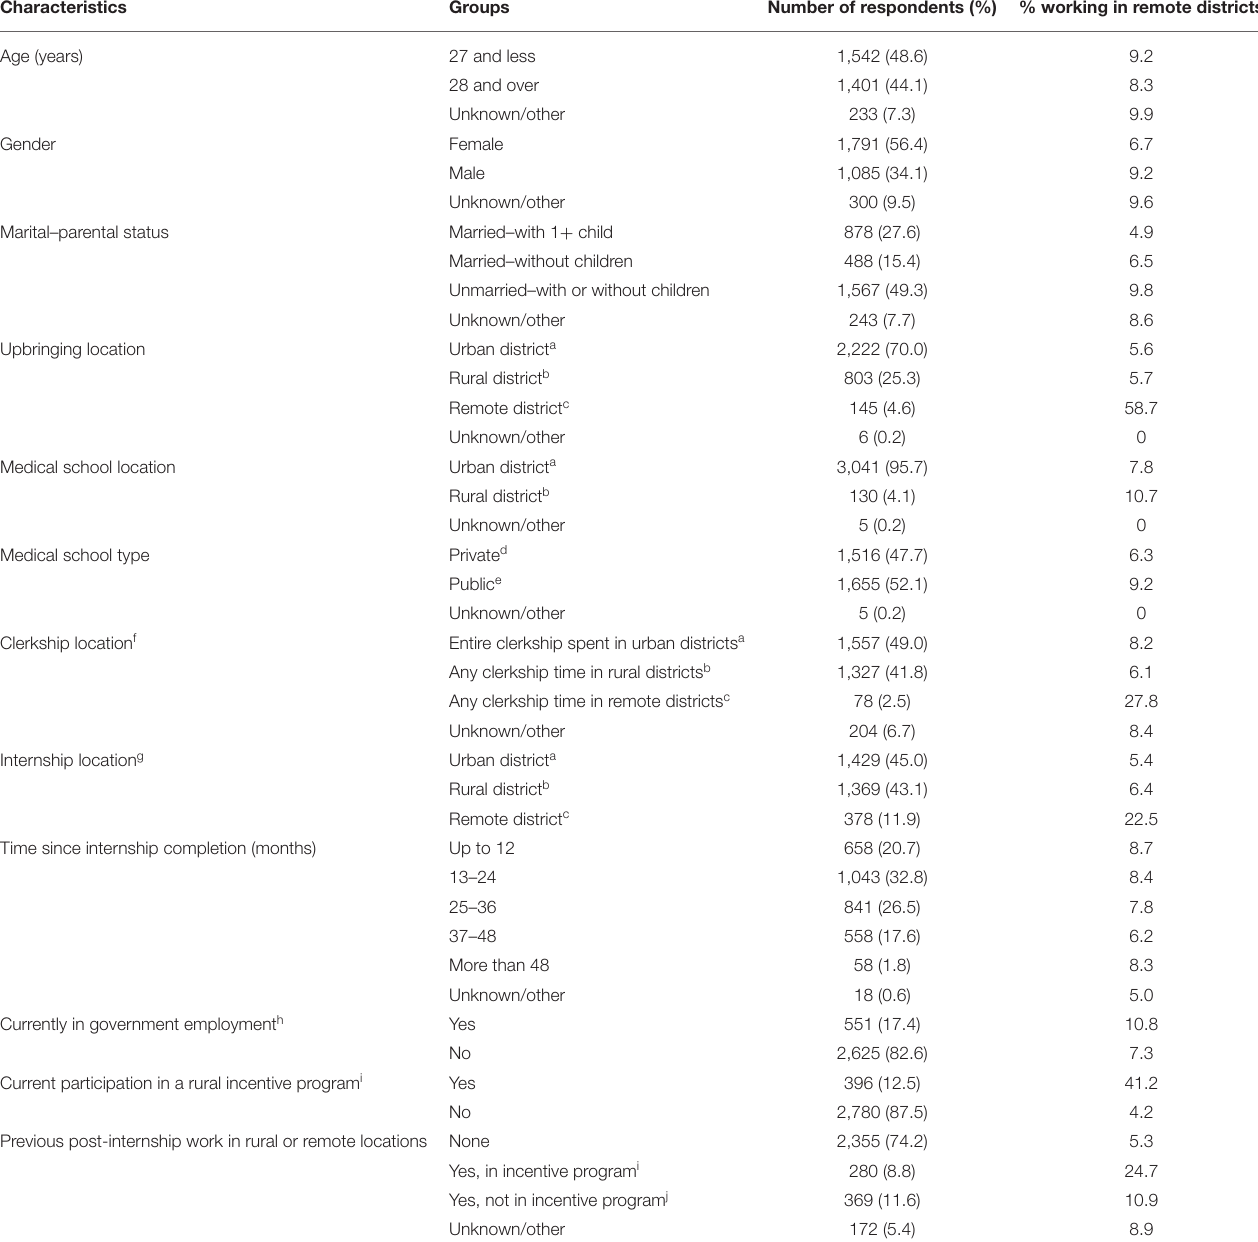
TABLE 1 | Sociodemographic characteristics of respondents.